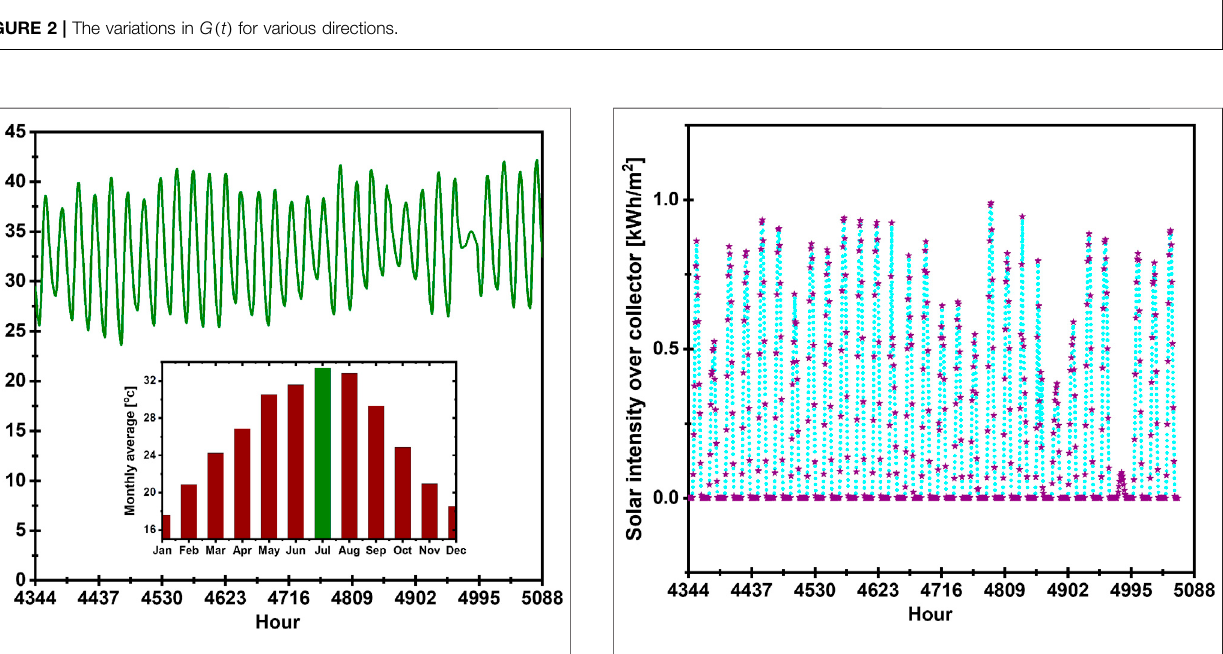
FIGURE 4 | The variations in. I ( t